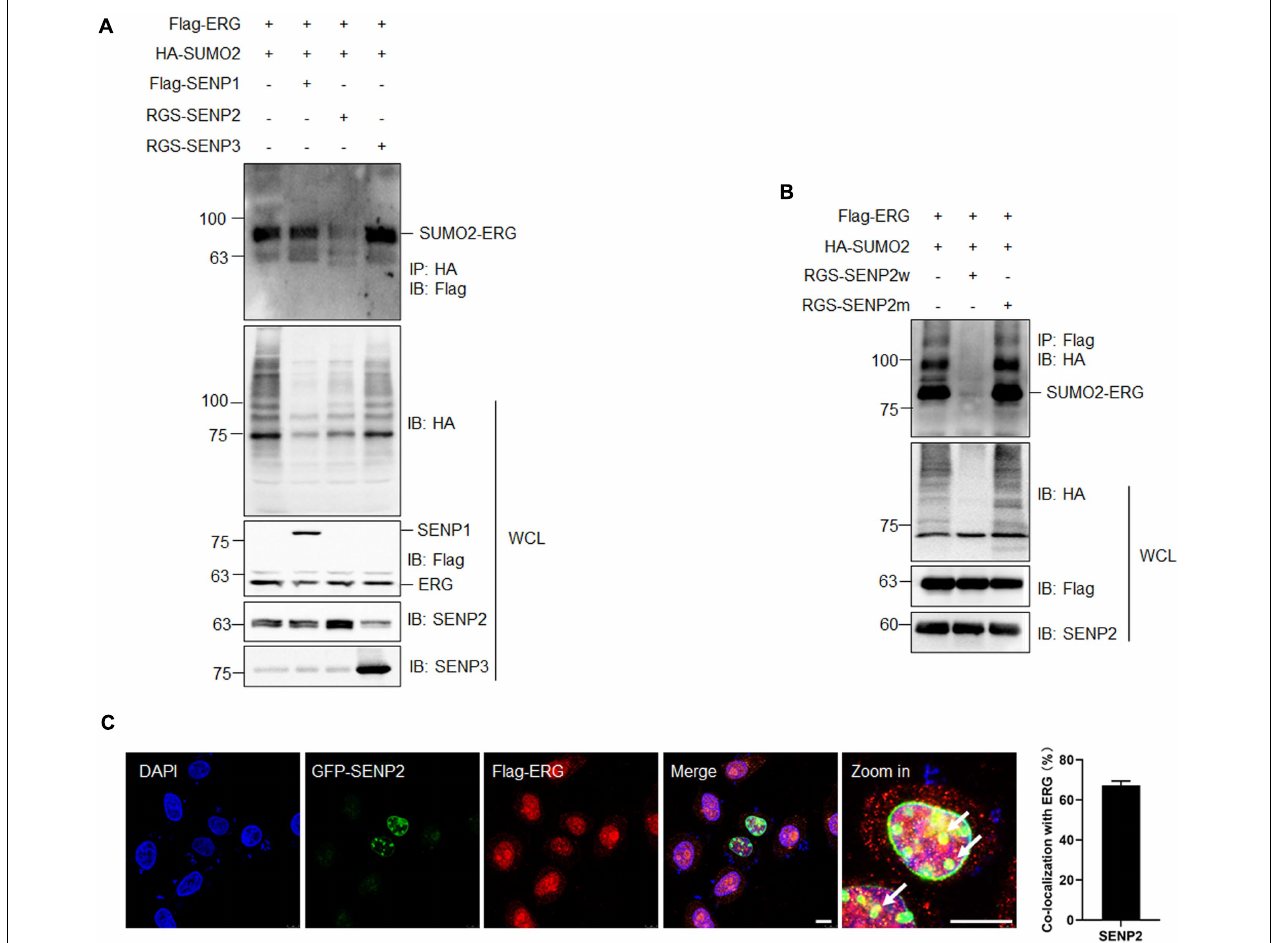
FIGURE 4 | SENP2 deconjugates SUMO2 from SUMOylated ERG. (A) SENP2 specifically deconjugated the SUMOylation of ERG. The indicated plasmids were transfected into HEK293T cells, and the IP with HA from cell lysates were detected by IB with anti-Flag antibody. The WCL were detected by IB with anti-HA, anti-Flag, anti-SENP2, or anti-SENP3 antibodies. (B) SENP2 wild type, but not catalytic mutant, specifically deconjugated the SUMOylation of ERG. The indicated plasmids were transfected into HEK293T cells, and the IP with Flag from cell lysates were detected by IB with anti-HA antibody. The WCL were detected by IB with anti-HA, anti-Flag, or anti-SENP2 antibodies. (C) ERG colocalized with SENP2 in the nucleus. The indicated plasmids were transfected into HEK293T cells, and cells were harvested for immunofluorescence staining with indicated antibodies (left). The results of quantitative analysis of co-localization are shown in the right panel ( n = 3 repeats/group, Student’s t -test). DAPI (blue) was used to show nuclei. The scale bar is 10 µ